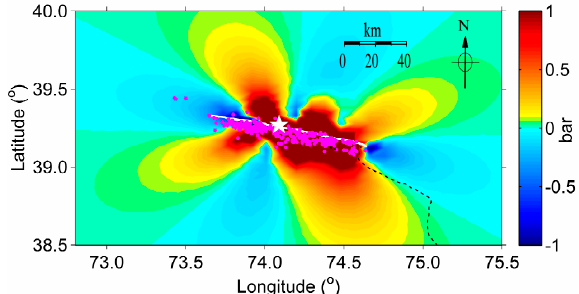
Figure 9. Static Coulomb failure stress changes due to the 2016 November 25 Aketao earthquake. The magenta-colored dots are the relocated aftershocks [1]. The epicenter is marked by a white star for clarity. The solid white line denotes the surface trace of the seismogenic fault, and the dashed black line represents the branched normal fault of the Kongur Shan extensional system [7].